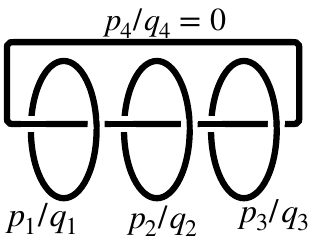
Figure 2 . Dehn surgery description of 3-fibered Seifert manifold S 2 (( p 1 , q 1 ) , ( p 2 , q 2 ) , ( p 3 , q 3 )) .